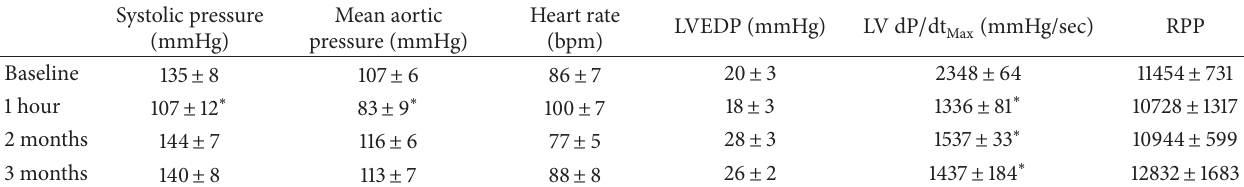
Table 1: The effects of coronary microembolization on